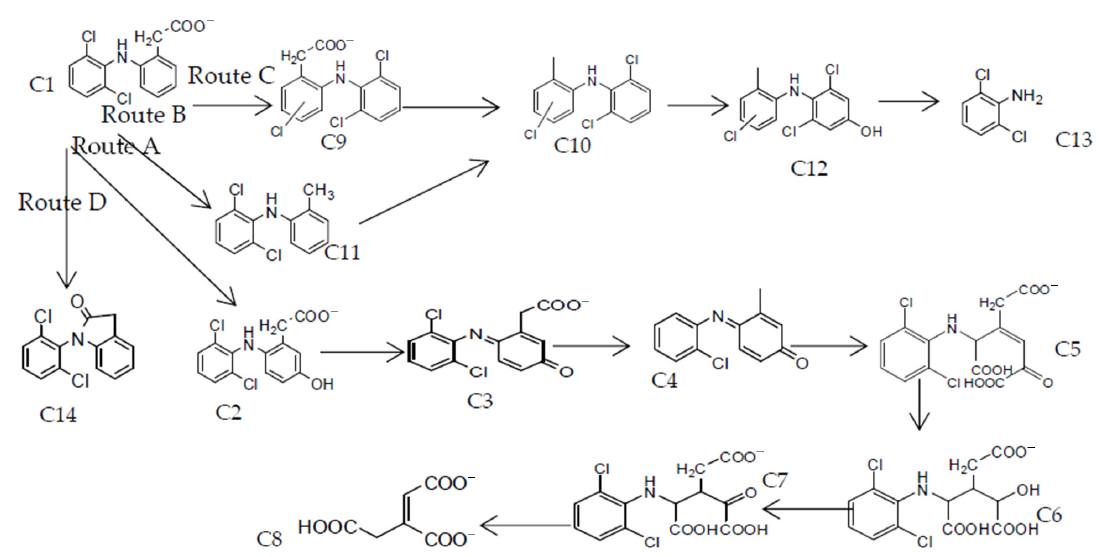
Figure 9. Proposed reaction pathway for the degradation of DCF by CWPO. Route A, C2 (5-hydroxy-diclofenac) indicates hydroxylation as one of the first steps [45]. Then, C3 (diclofenac-2, 5-iminoquinone) is formed from C2 (5-hydroxy-diclofenac) by • OH attack and abstraction of H • [46]. Subsequent decarboxylation on C3 (diclofenac-2, 5- iminoquinone) produces C4 (m/z 229.8) by • OH attack. The cleavage of C4 caused by • OH leads to form C5 (m/z 375), and then the decarboxylation of C5 generates C6 (m/z